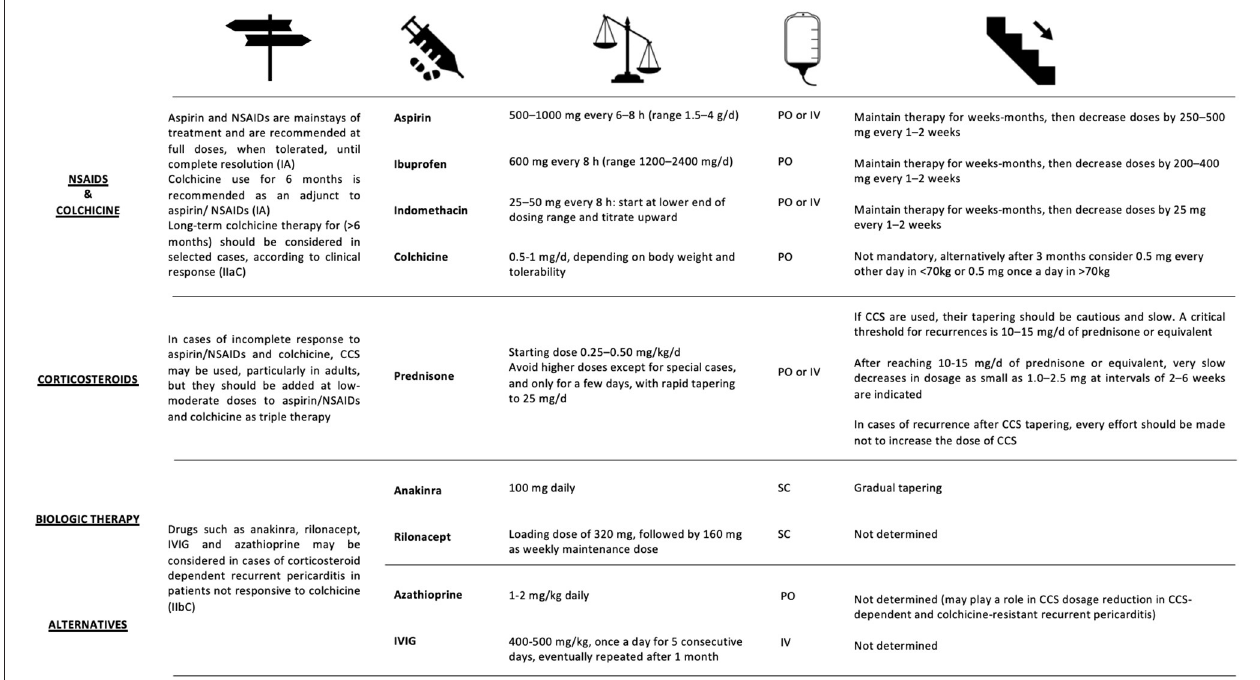
FIGURE 7 | Immunosuppressive treatment strategies used for acute and recurrent pericarditis. In brackets are reported recommendation and level of evidence based on guidelines. NSAIDs, non-steroidal anti-inflammatory drugs; h, hours; d, day; PO, per os; IV, intravenous; CCS, corticosteroids; IVIG, intravenous immunoglobulin; SC, subcutaneous. Adapted from Adler et al. (